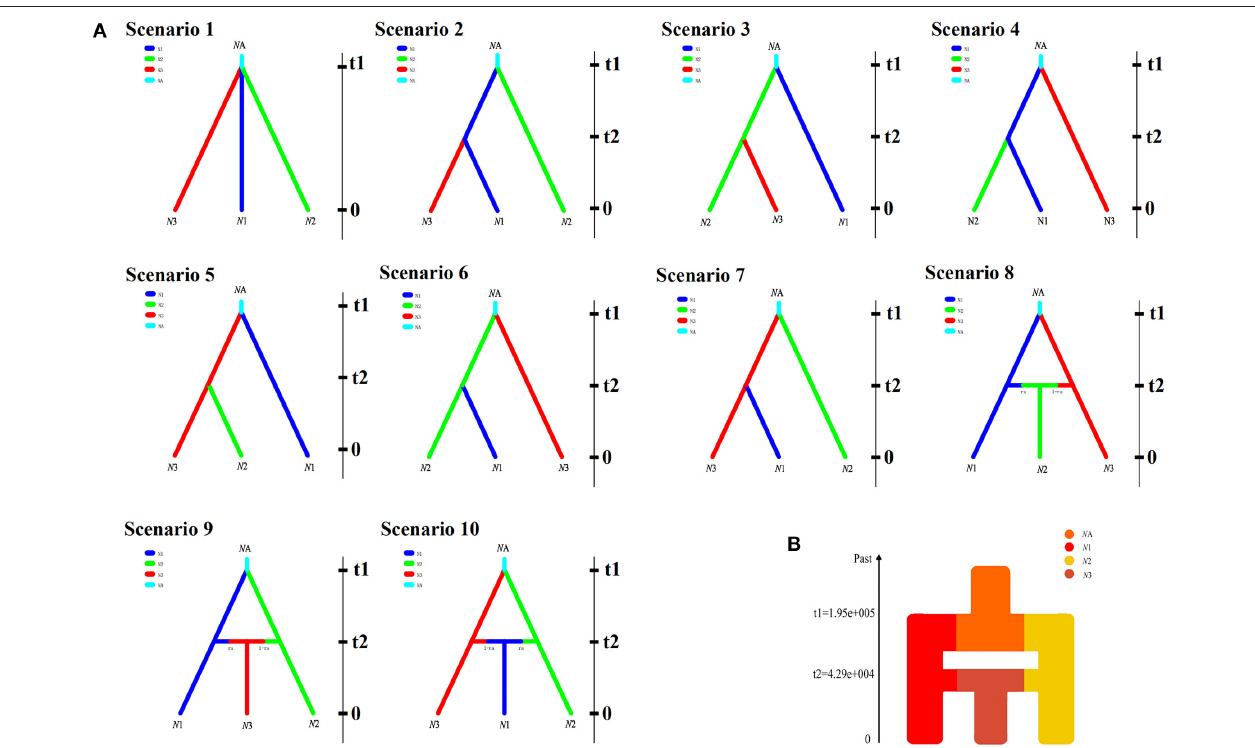
FIGURE 3 | (A) The 10 scenarios of population history of five populations in Rhinopithecus roxellana in Qinling Mountains with DIYABC V 2.04. N 1, N 2, and N 3 denote the current population lineages, while N A represents the ancestral population lineage. t1 and t2 are divergence times for the depicted event. (B) Schematic representation of changes in population size tested within the three population